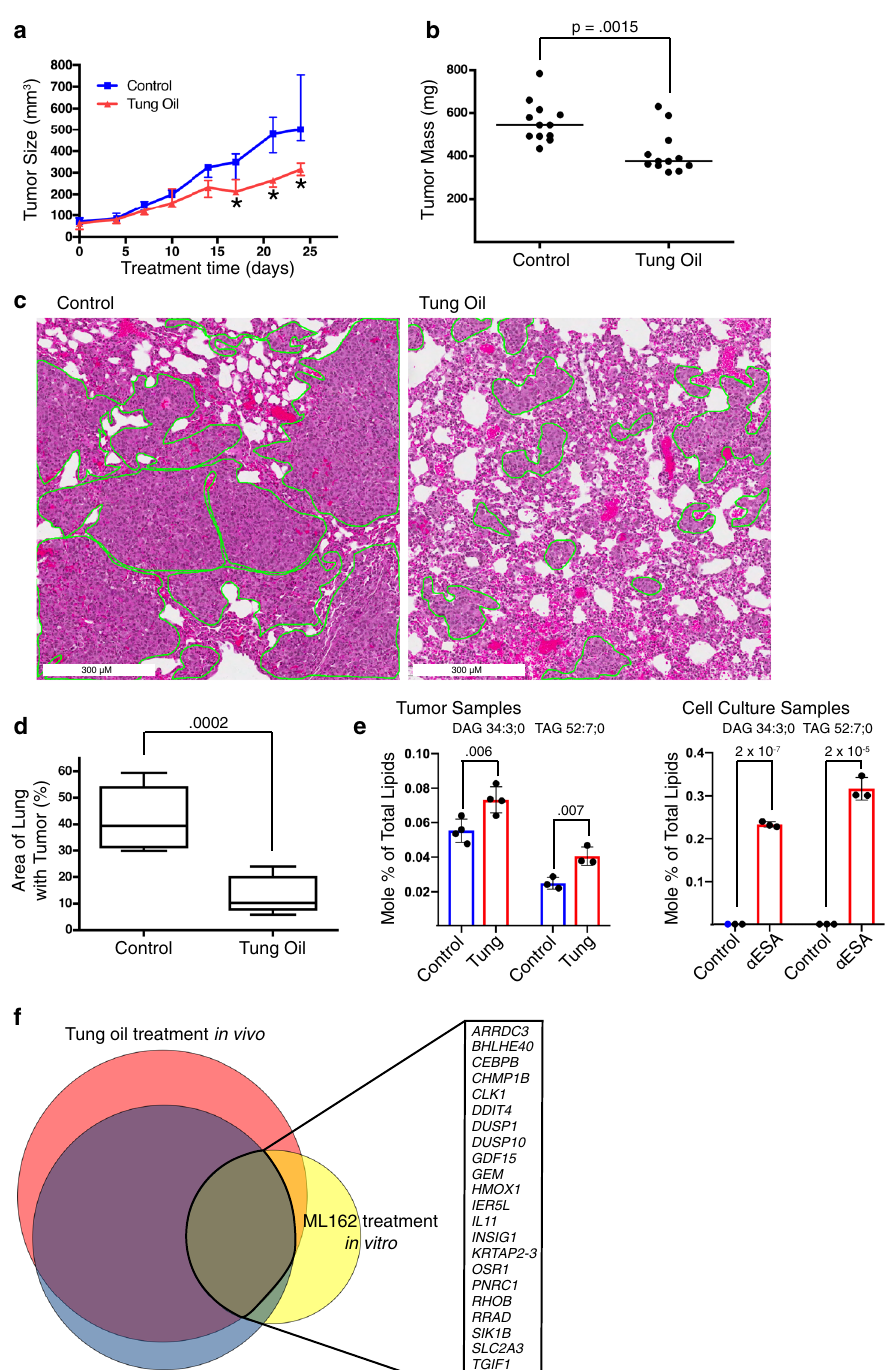
mammals, in lipid droplets may promote their oxidation and polymerization there. Propagation of lipid peroxidation from lipid droplets to membrane phospholipids may be mediated by diffusion of soluble mediators (Fig. 8f, g). The formation of large covalent lipid polymers in lipid droplets may also trigger an autophagic response 61 which could drive ferroptosis 62 . A model in which accumulation of conjugated linolenic acyl chains in lipid droplets initiates ferroptosis may also explain the differences in ACSL isoform roles between ferroptosis triggered by α ESA and by GPX4 inhibitors. GPX4 inhibitors suppress the antioxidant response, allowing natural lipid ROS species to